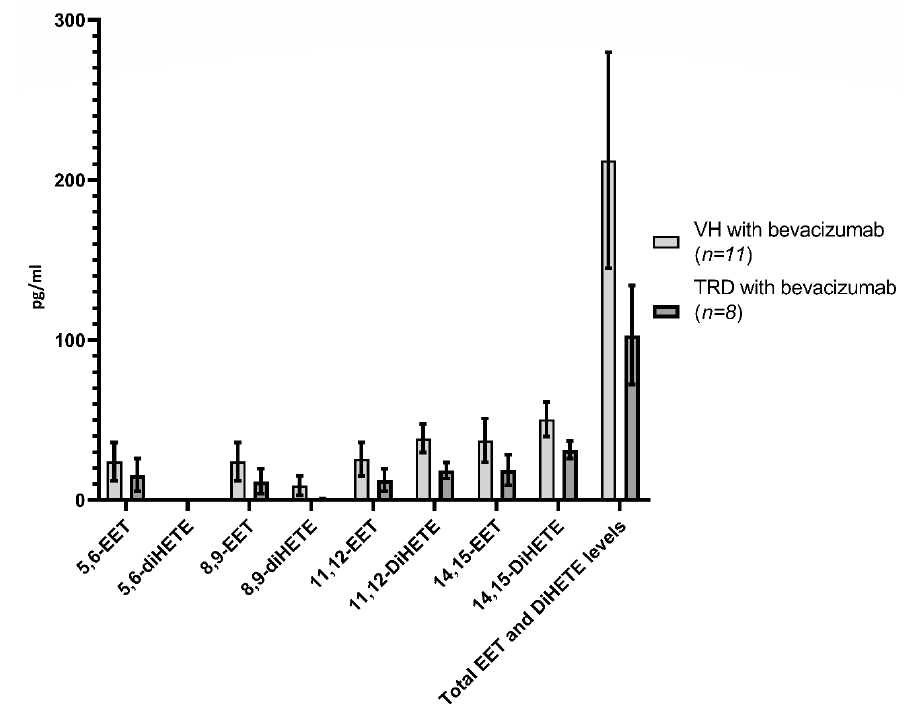
Figure 6. Human vitreous levels of eicosanoids in PDR subtypes treated with bevacizumab, VH ( n = 11) vs. TRD ( n = 8) eyes. Comparison of levels (pg / mL) of individual EET and DiHETE as well as total levels in VH vs. TRD.